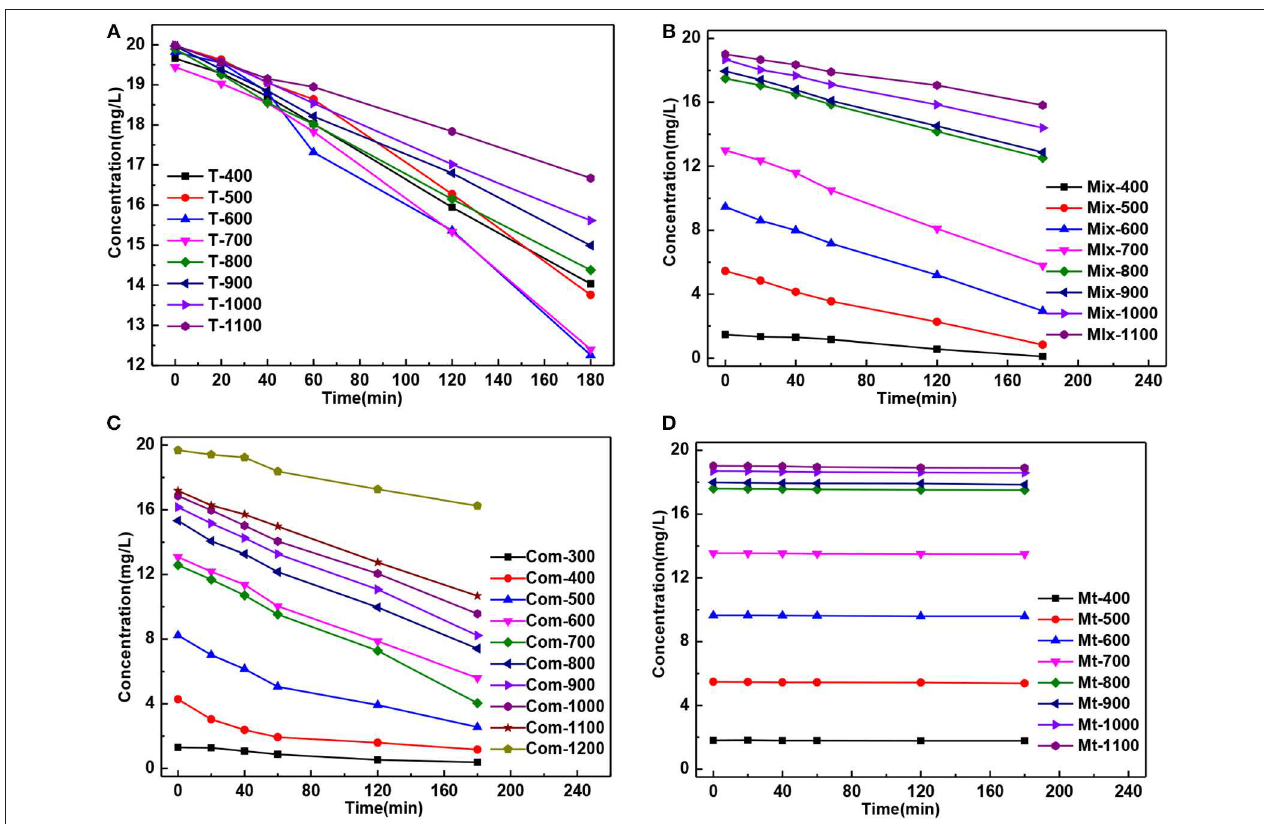
FIGURE 5 | The curve of MB residual concentration of solution degradation by the (A) T, (B) Mix, (C) Com, and (D) Mt calcinated at the different temperatures vs. the time of